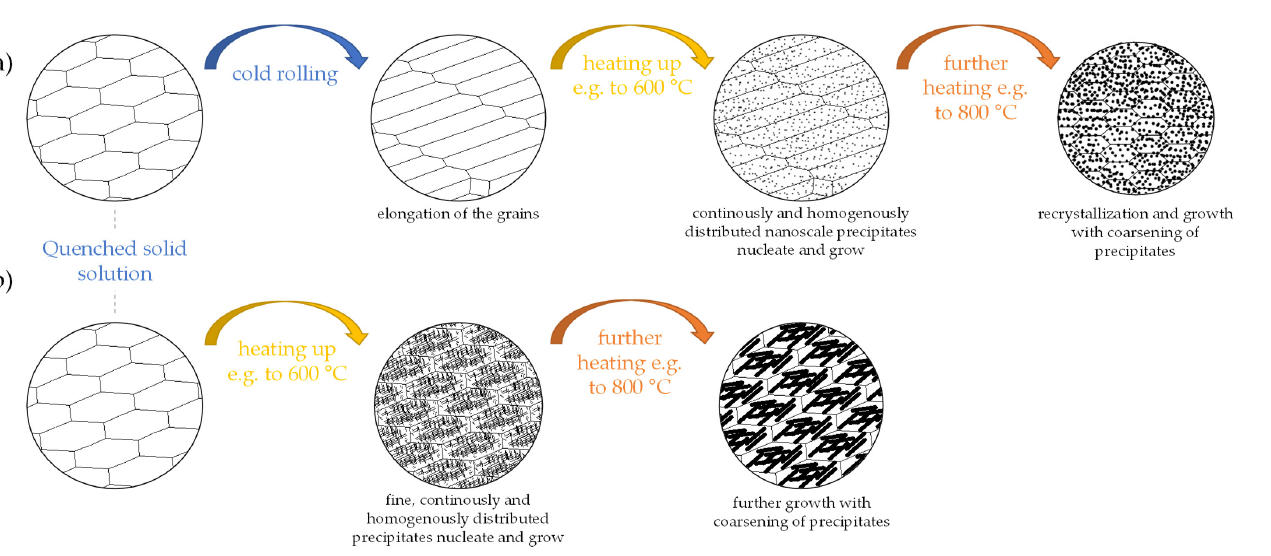
Figure 13. Precipitates of CuHf0.7 in their evolution during DSC measurements: cold rolled specimen with 75% cross section reduction; ( a ) condition 1; ( b ) condition 2; showing precipitates preferentially at crystallographic defects along slip bands (1), coarsening precipitates at higher temperatures (2), and newly built grains during recrystallization (3).